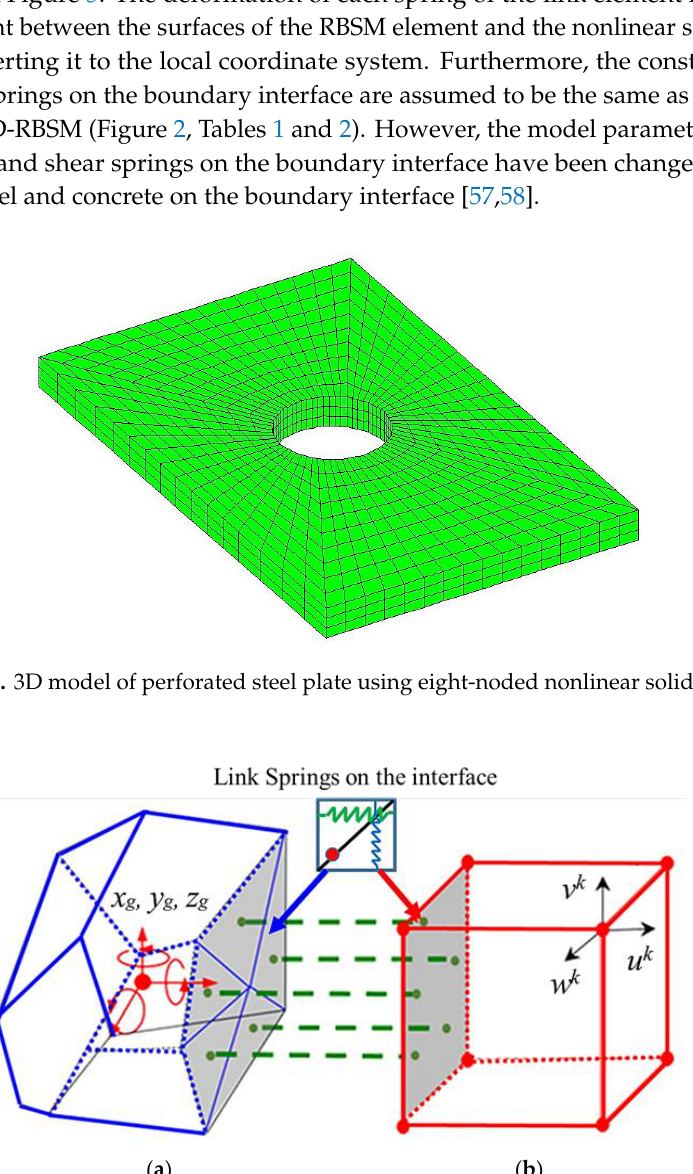
Figure 4. 3D model of perforated steel plate using eight-noded nonlinear solid FEM.